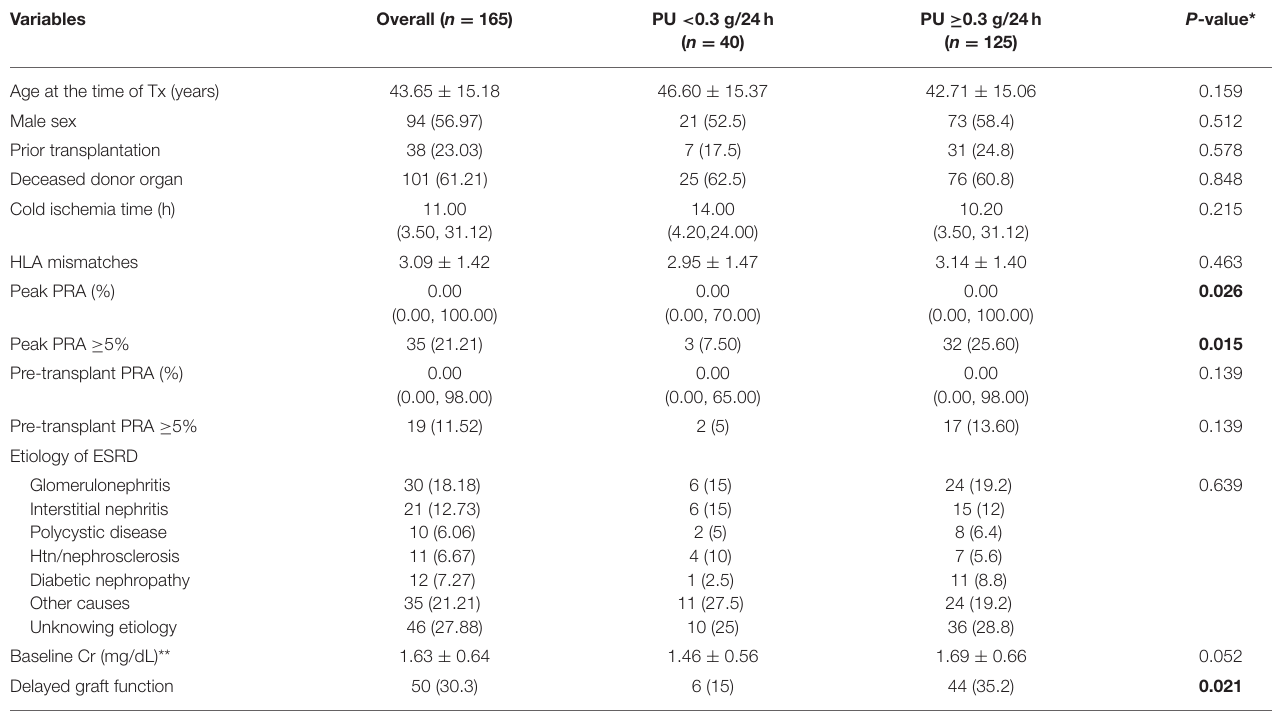
TABLE 1 | Baseline demographics and clinical characteristics of TG